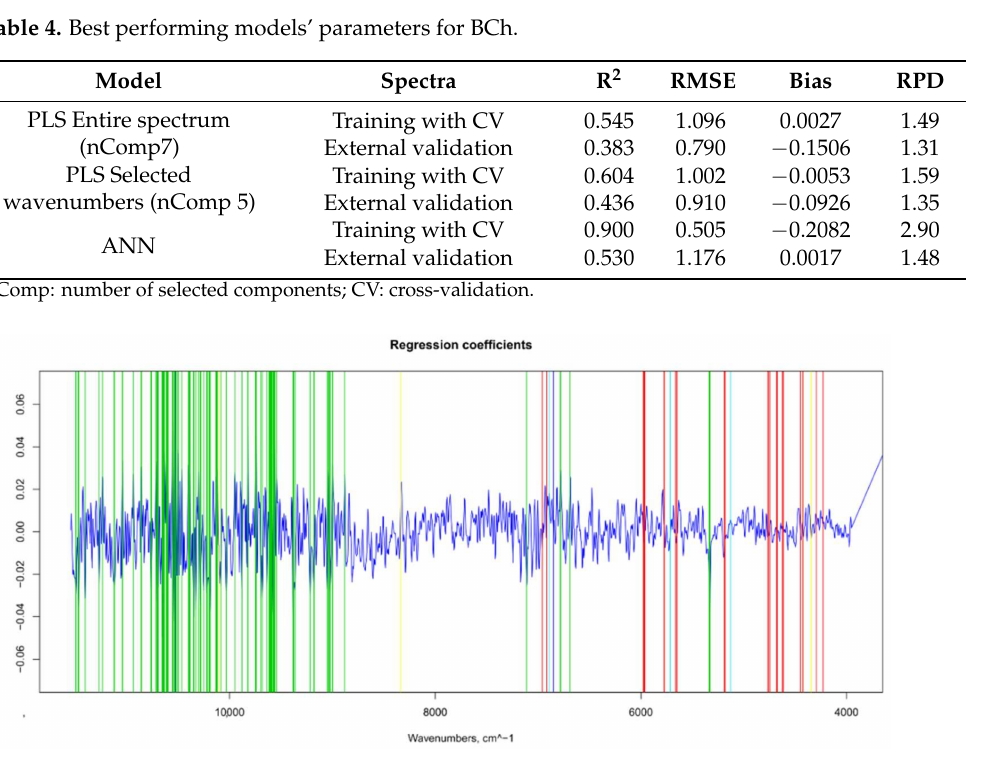
Figure 17. Beta-coefficient values after outlier removal and mean center: values selected for ANN (in green), main NIR peaks for water (in blue), sugar and water (in light blue), sugar and organic acids (in yellow), and pectins (in